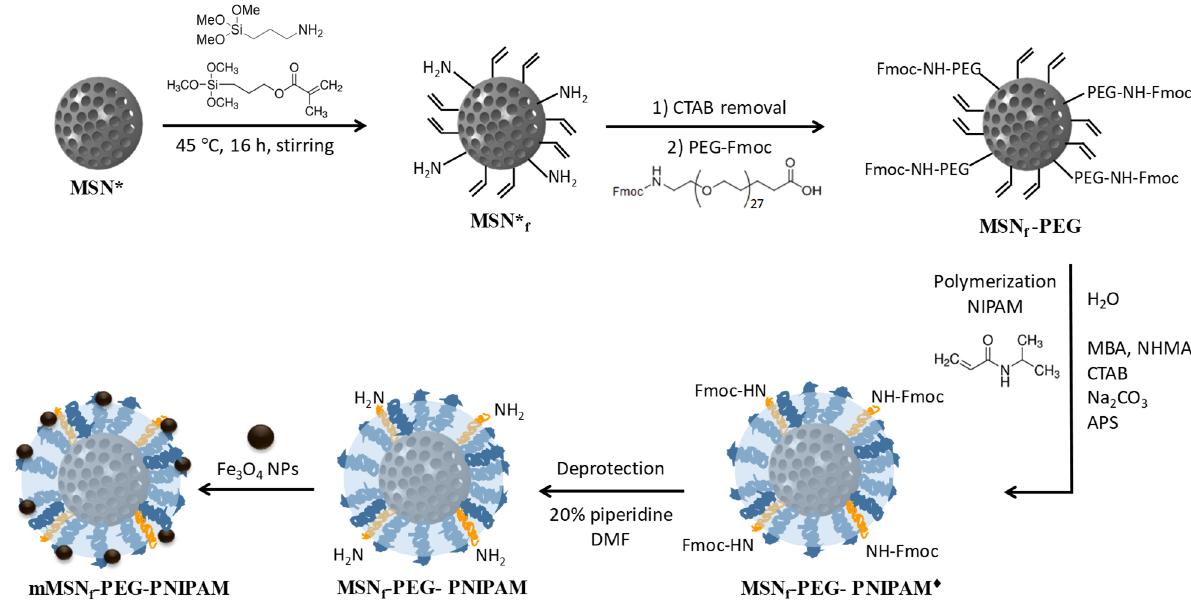
Figure 1. Synthetic steps carried out to obtain the mMSN f -PEG-PNIPAM nanosystem: MSNs with the surfactant inside the mesopores were used as starting materials (MSN*); surface modification of MSN* with methacrylate and aminopropyl groups by using MPS and APTES, respectively (MSN f *); surfactant removal followed by grafting of Fmoc-NH-(PEG) 27 -COOH (MSN f -PEG); polymerization of N -isopropylacrylamide (MSN f -PEG-PNIPAM ♦ ); deprotection of Fmoc to leave amino groups available (MSN f -PEG-PNIPAM); and grafting of Fe 3 O 4 NPs to MSN f -PEG-PNIPAM (mMSN f -PEG-PNIPAM).